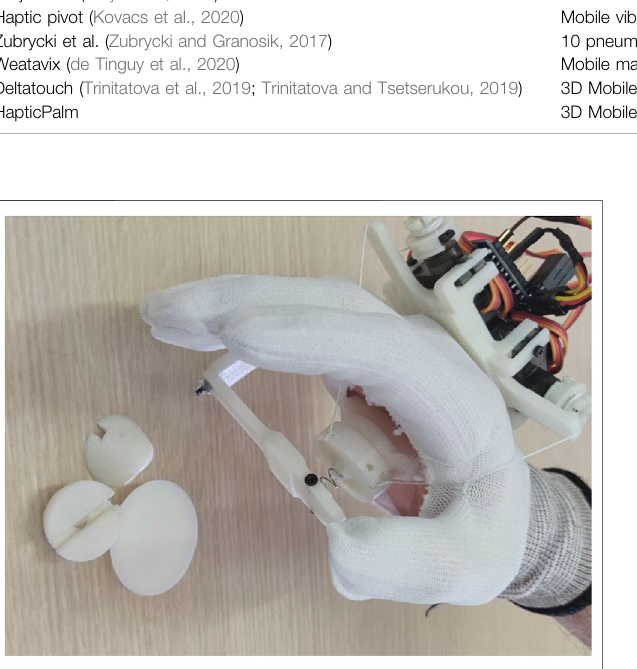
FIGURE 1 | Prototype of the wearable haptic device for hand palm stimulation worn by a